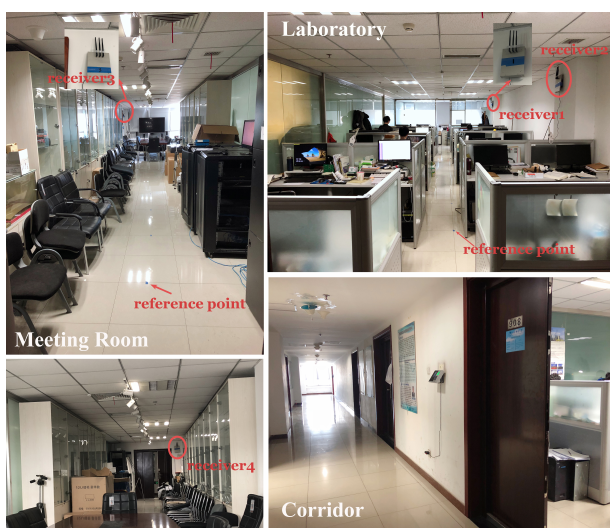
Figure 12. Experimental environments of the integrated NLOS room combined with laboratory, meeting room and corridor.